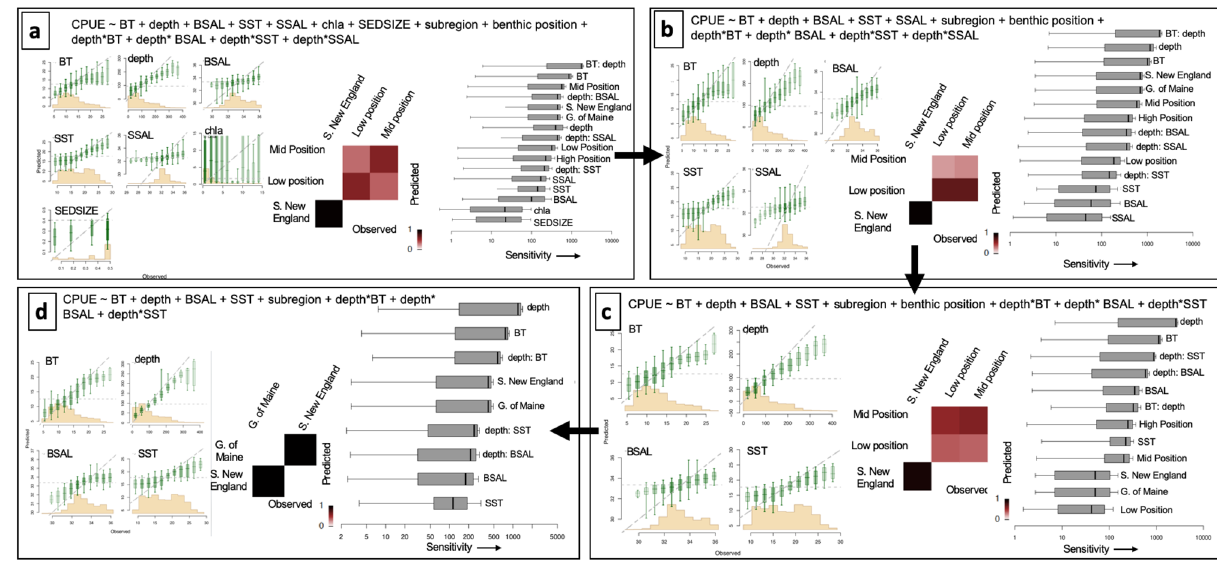
Figure 1. Inverse prediction and sensitivity for combinations of environmental parameters in GJAM. Starting with the most complicated model ( a ), sensitivity was highest for the interaction between BT and depth and lowest for Chla and sediment size ( a ). Inverse prediction confirms that sediment size and Chl a contribute little to community biomass ( a ) and those are removed in the second model ( b ). SSAL contributes little to community response and are removed in the third model ( c ), The final model ( d ) includes terms that have strong inverse prediction and overall sensitivity. Inverse prediction for continuous and factor variables is on the left and center of each box, and overall sensitivity is on the